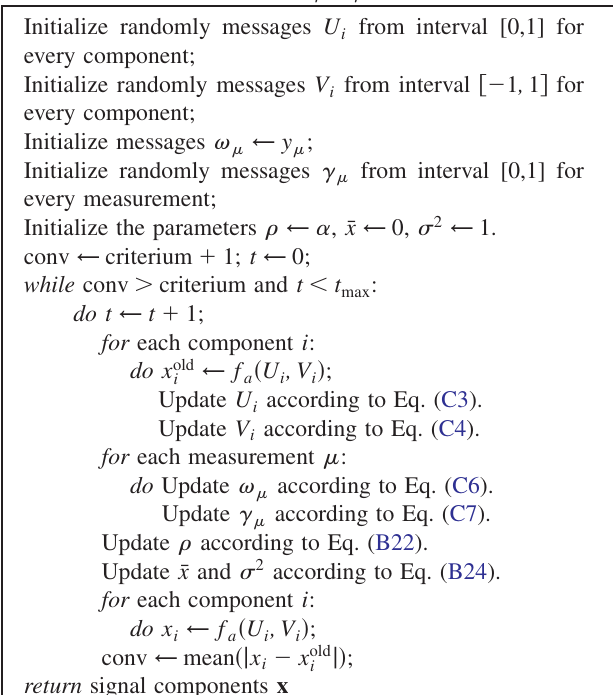
Algorithm 1. EM - BP ð y